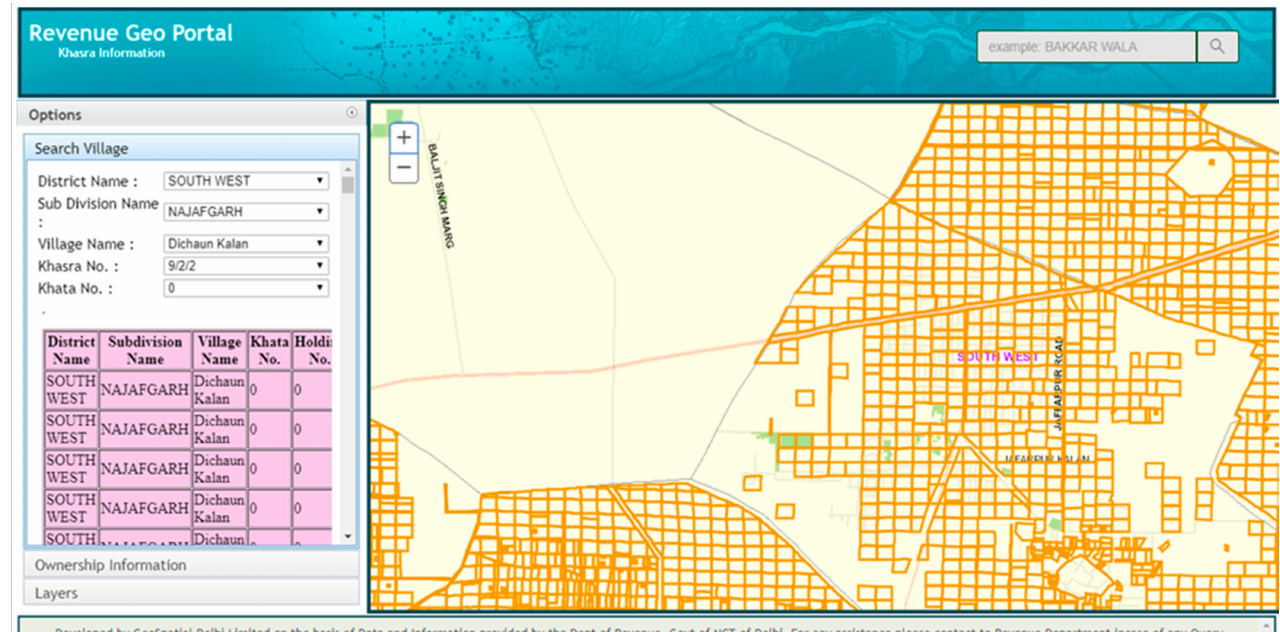
Figure 4. Geographical information system (GIS) enabled portal for revenue purposes in Delhi; (Source: